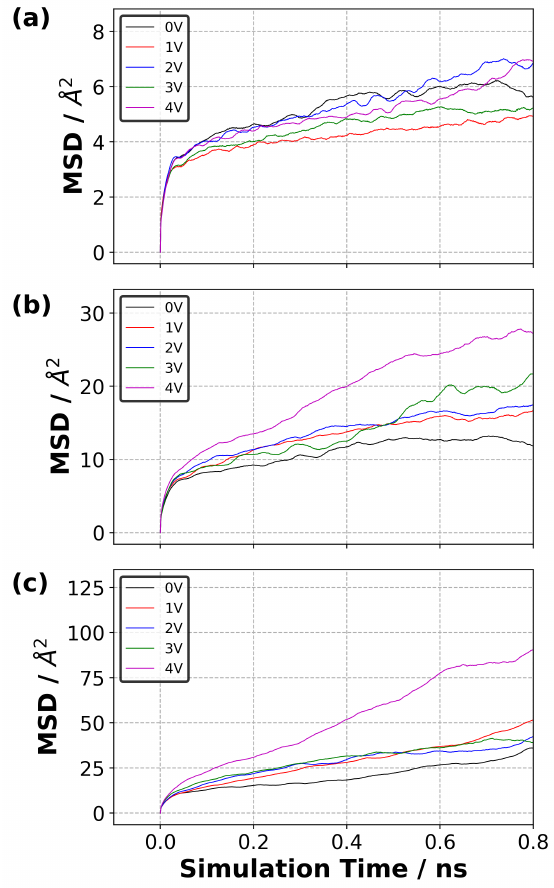
Figure 8. Mean square displacement (MSD) curves for the anion that is found in the electric double layer (EDL) (the thickness of 10 Å from the positive electrode) obtained at different potential difference and temperature: ( a ) 300 K, ( b ) 400 K and ( c ) 500